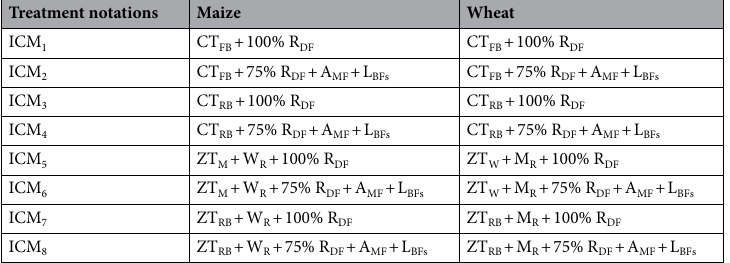
−1 ; L BFs = NPK liquid